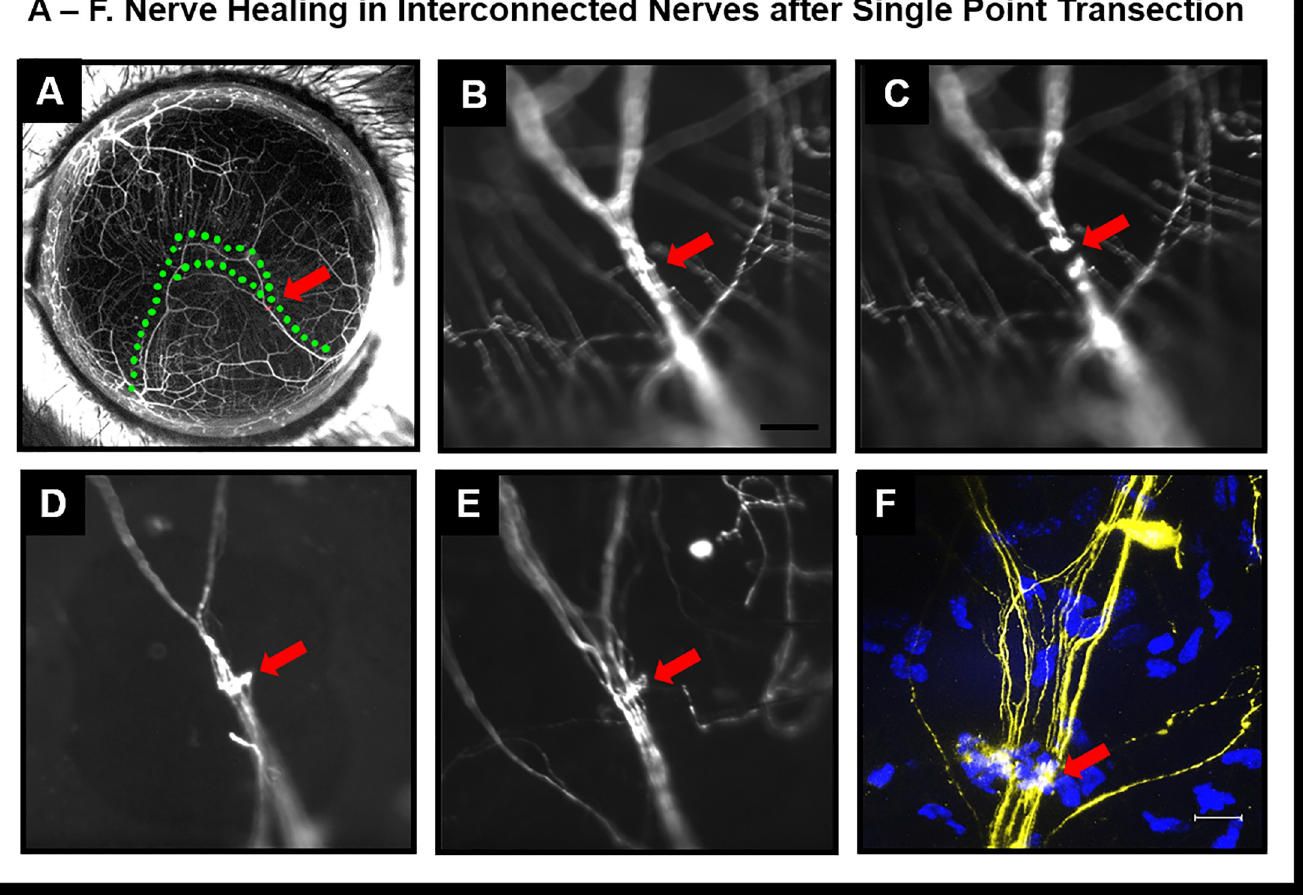
Fig 4. Nerve healing in interconnected nerves after single point transection. (A): Stereofluorescent image of cornea prior to nerve transection (red arrow indicates point of planned transection; green dotted lines mark the interconnected nerves. (B-E) Wide-field fluorescent image showing nerve prior to transection (B), immediately after transection (C), four weeks after transection (D) and six weeks after transection (E). (F) Confocal image of transected area.